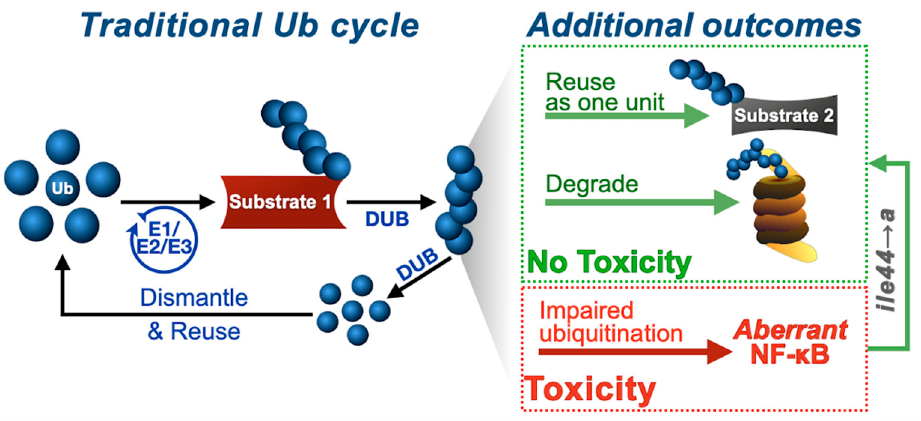
Figure 8. Summary of potential outcomes of ubiquitin recycling. “Traditional Ub cycle”: ubiquitin is attached to a substrate protein either as a monomer (not shown) or as a polymer. Poly-ubiquitin can be removed as a single unit by DUBs, dismantled into mono-ubiquitin, and then reused. “Additional outcomes”: based on our studies in Drosophila from earlier investigations and from this work, unanchored poly-ubiquitin can be reused as a single unit and become attached onto another protein [26], or can be degraded ([26] and this work). If handled as described thus far, unanchored chains are not detrimental (No Toxicity). However, if the ability of cells to reuse or to ubiquitinate free poly-ubiquitin as described here is hampered, unanchored chain toxicity results from cellular pathway perturbation, as with NF-kB processes evidenced here (Toxicity). Based on our data, this toxicity is reversed by an isoleucine 44 to alanine mutation that disrupts a critical interaction site on ubiquitin.